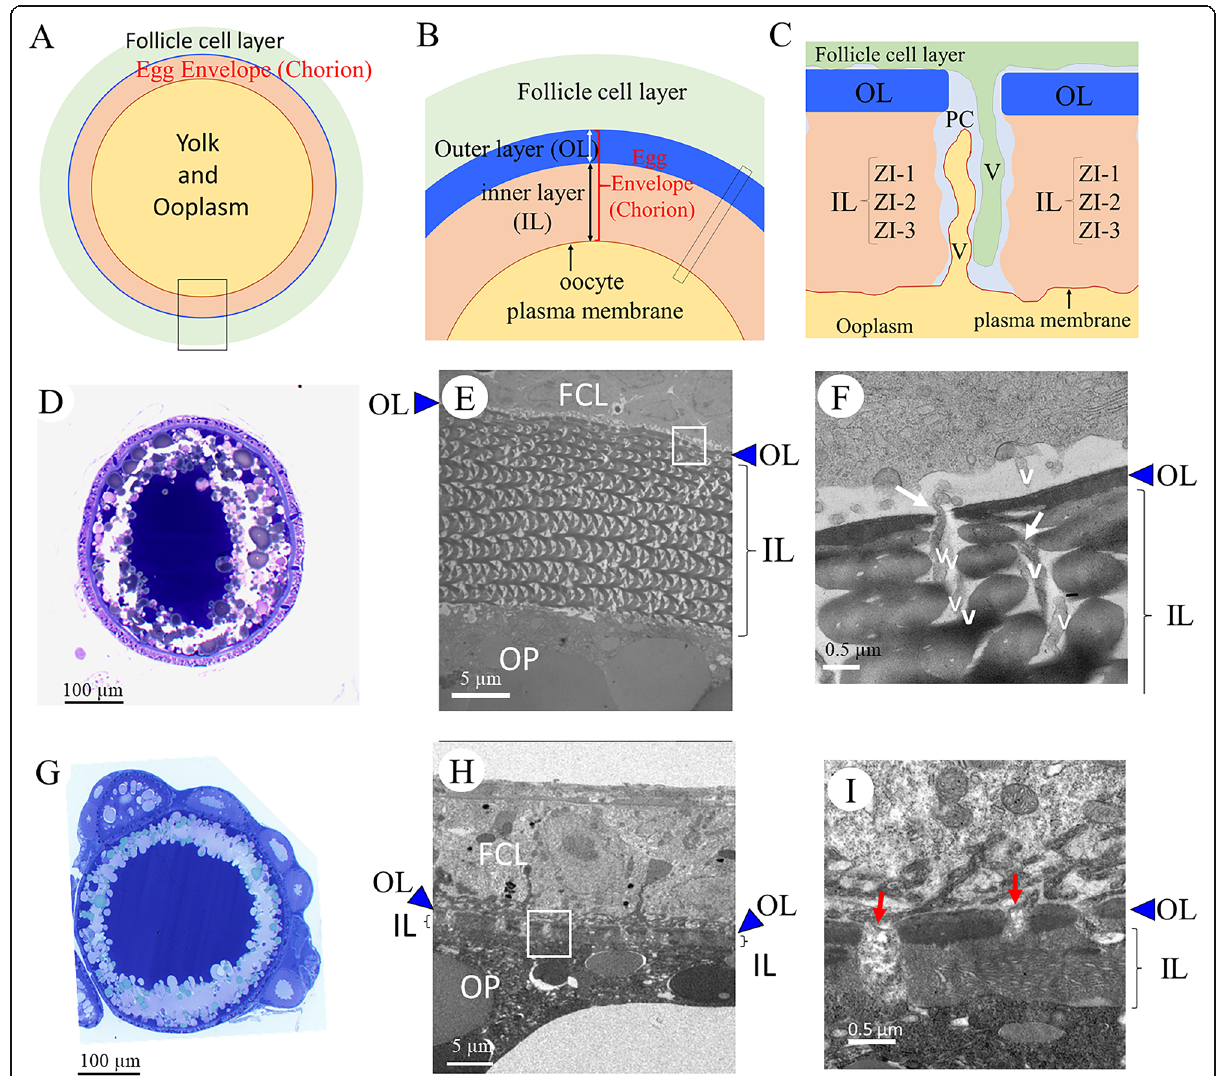
Fig. 4 Morphological characterization of ovarian oocytes in the chg.l+/+ and chg.l − / − females. A-C Schematic illustrations of the structure of the ovarian chg.l+/+ medaka egg under different magnifications. B Enlarged illustration at the position of the rectangle in A. C Enlarged illustration at the position of the rectangle in B, showing microvilli (v) from the follicle cell layer (FCL), ooplasm, and pore canal (PC). D-F Light micrograph ( D ) and Transmission Electron micrographs ( E-F ) of the chorion in the chg.l+/+ female. G-I Light micrograph of the ovarian oocyte ( G ) and Transmission Electron micrographs ( H-I ) of the chorion in the chg.l − / − female. F and I Magnified images of the chorion marked by white squares in E and H , respectively. Symbols – Panels E-F and H-I OL and dark blue arrowheads with a black outline mark the position of the chorion externa. IL and brackets mark the position of the chorion interna. Panel F White arrows mark the position of the pore canal. Panel I Red arrows mark large pore canal-like structures. Scale bars in D and G = 100 μ m; in E and H = 5 μ m; and in F and I = 0.5 μ